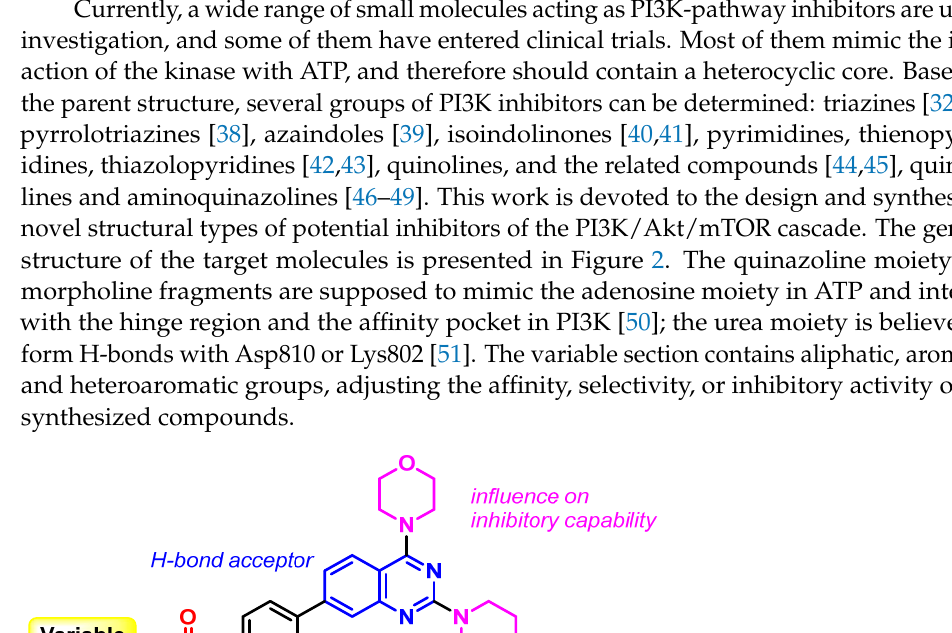
Figure 1. FDA ‐ approved inhibitors of PI3K/Akt/mTOR pathway [2,30,31].